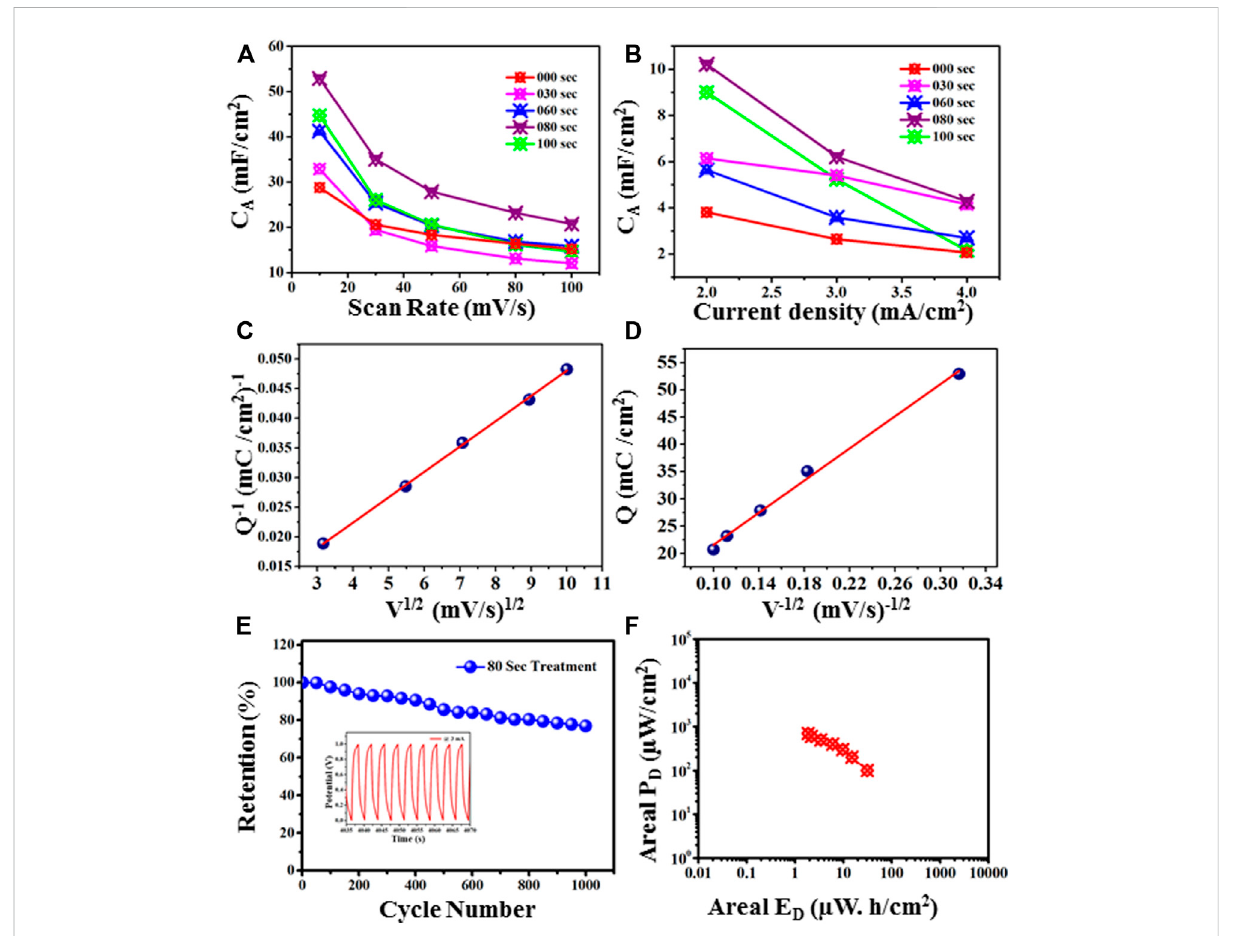
FIGURE 14 (A) Areal capacitance behaviour at different scan rates. (B) : Areal capacitance behaviour at different current densities. (C) Plot of Q − 1 vs. V 1/2 to fi nd the total stored charge. (D) Plot of Q vs. V − 1/2 to fi nd the charge stored on the outer surface of the electrode material. (E) Cyclic stability at 3 mA, (F) Ragone plot of 80 s Treatment sample.